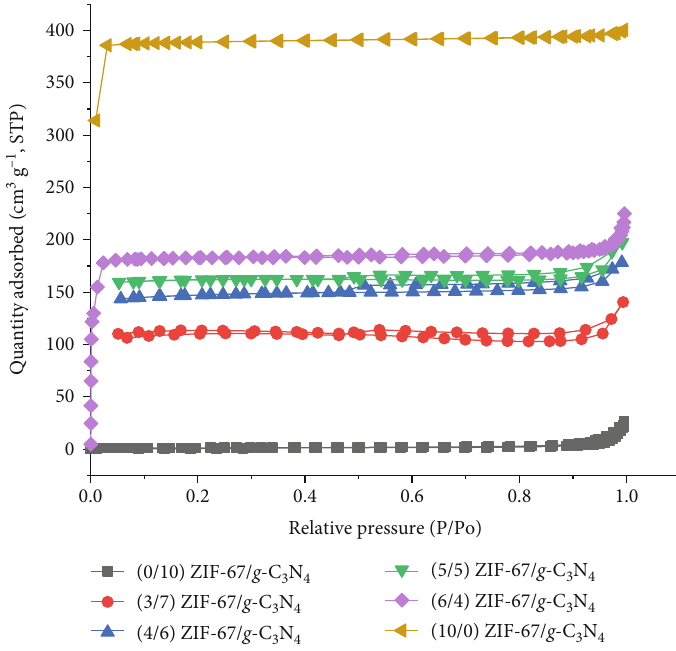
Figure 2: Nitrogen adsorption/desorption isotherms of ZIF-67, g -C